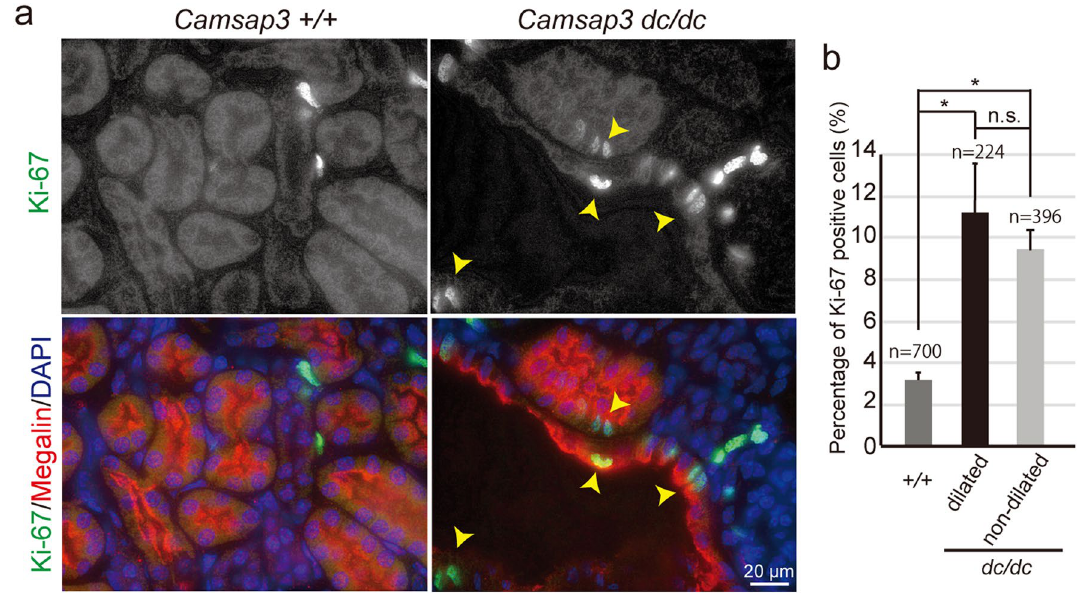
Figure 4. Cell proliferation in Camsap3 dc/dc PCTs. ( a ) Immunostaining for Ki-67, Megalin, and DAPI in WT and Camsap3 dc/dc kidneys at P22. Arrowheads indicate Ki-67–positive cells in cystic tubules. ( b ) Percentage of Ki-67–positive cells within PCT epithelial cells [+ / +, n = 700 cells; dc/dc (dilated), n = 224 cells; dc/dc (non- dilated), n = 396 cells]. Error bars indicate S.D. * p < 0.05,